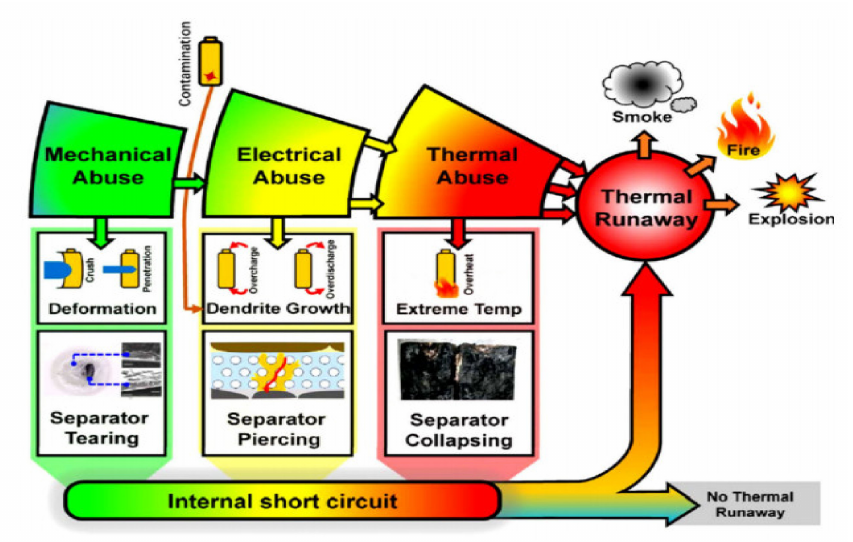
Figure 3. Various abuse conditions of thermal runaway and